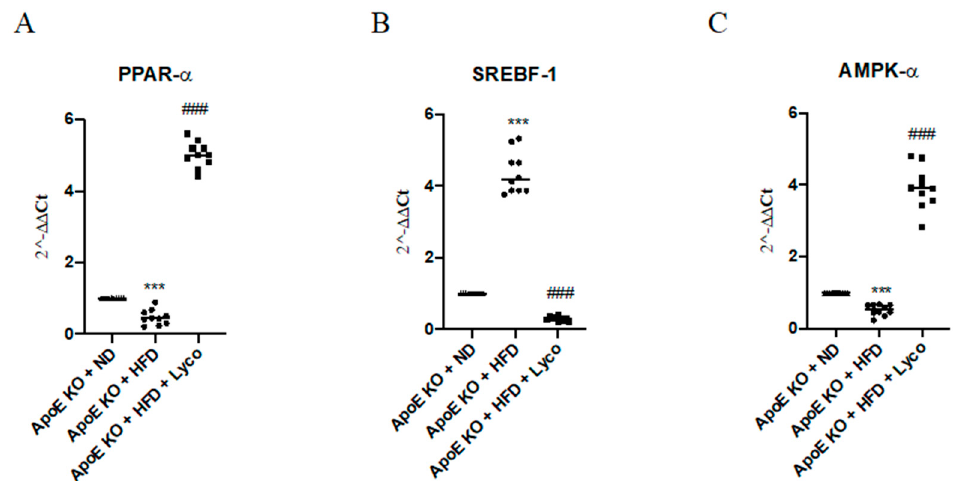
Figure 6. The graphs represent qPCR results of PPAR- α ( A ), SREBF-1 ( B ), AMPK- α , and ( C ) mRNA expression from liver samples. Values were obtained from 10 animals per group and are expressed as the means and SD.*** p < 0.0001 vs. ApoE KO + ND; ### p < 0.0001 vs. ApoE KO +